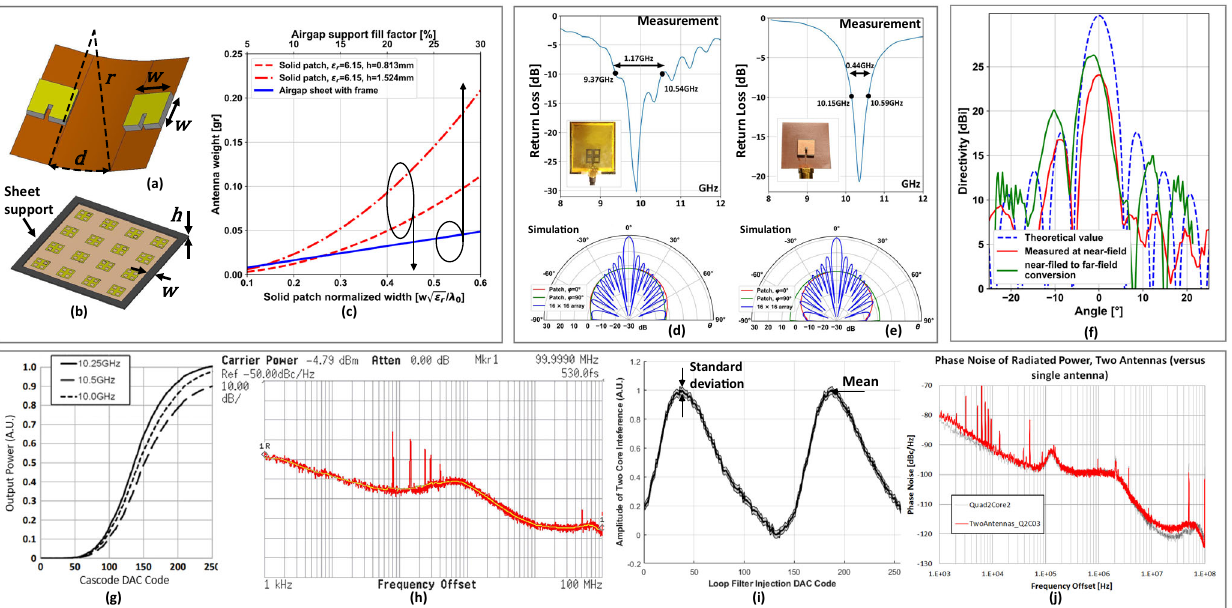
Fig. 7 Measurement and design details. a Dielectric patch antenna structure and implication on fl exibility and b air gap patch and dimensions of glass fi ber support. c Antenna mass as a function of dimensions, or support fi ll-factor. Matching and radiation patterns of d air gap and e dielectric patch radiators. f Measured directivity of near- and far- fi eld patterns compared to analytical value. g – j Show RFIC functionality. g Normalized cascode amplitude control at three frequencies. Re-used with permission from 75 . h Signal spectrum. Re-used with permission from 25 . i Radiative measurement of interference pattern demonstrating independent phase control of driver cores within the same current-sharing stack. Mean and standard deviation of ten trials plotted. j Radiative phase noise measurement of one core and two